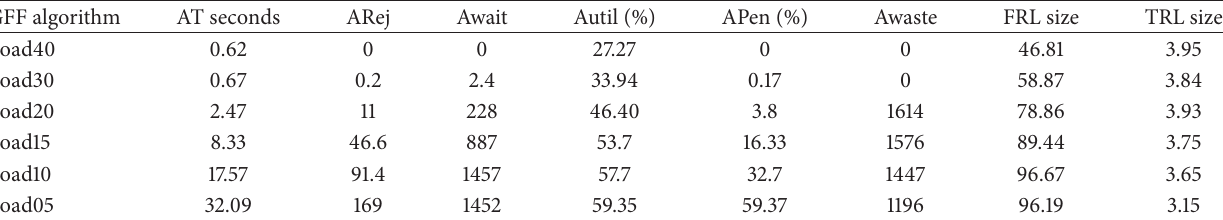
Table 2: Performance metric for RBG code in first fit